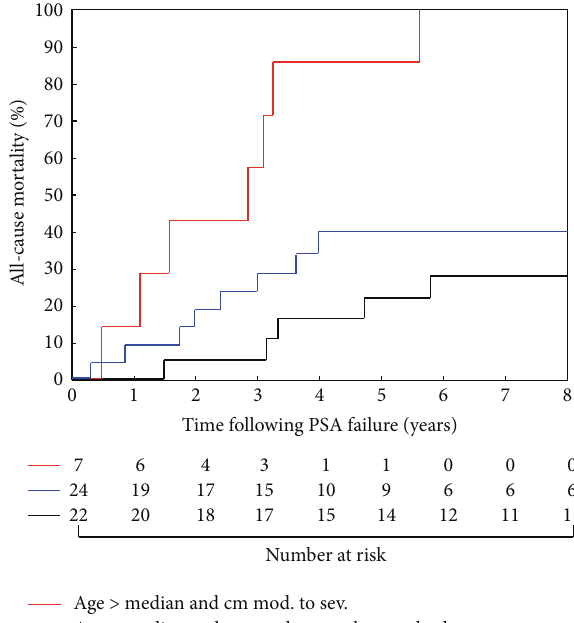
Figure 1: One minus Kaplan Meier estimates of all-cause mortality following PSA failure for subgroups based on the median age at failure (76.6 years) and presence or absence of ACE-27 defined moderatetoseverecomorbidity(CM).Menolderthanthemedianat the time of PSA failure and who had moderate to severe comorbidity were significantly more likely to die compared to men with only one ofthosefeatures( 𝑃 = 0.003 )ormenwhohadneitheradversefeature ( 𝑃 < 0.001 ). No significant difference was identified between men with one or neither risk factor ( 𝑃 = 0.14 ). Significance is defined as 𝑃 < 0.0167 per Bonferroni